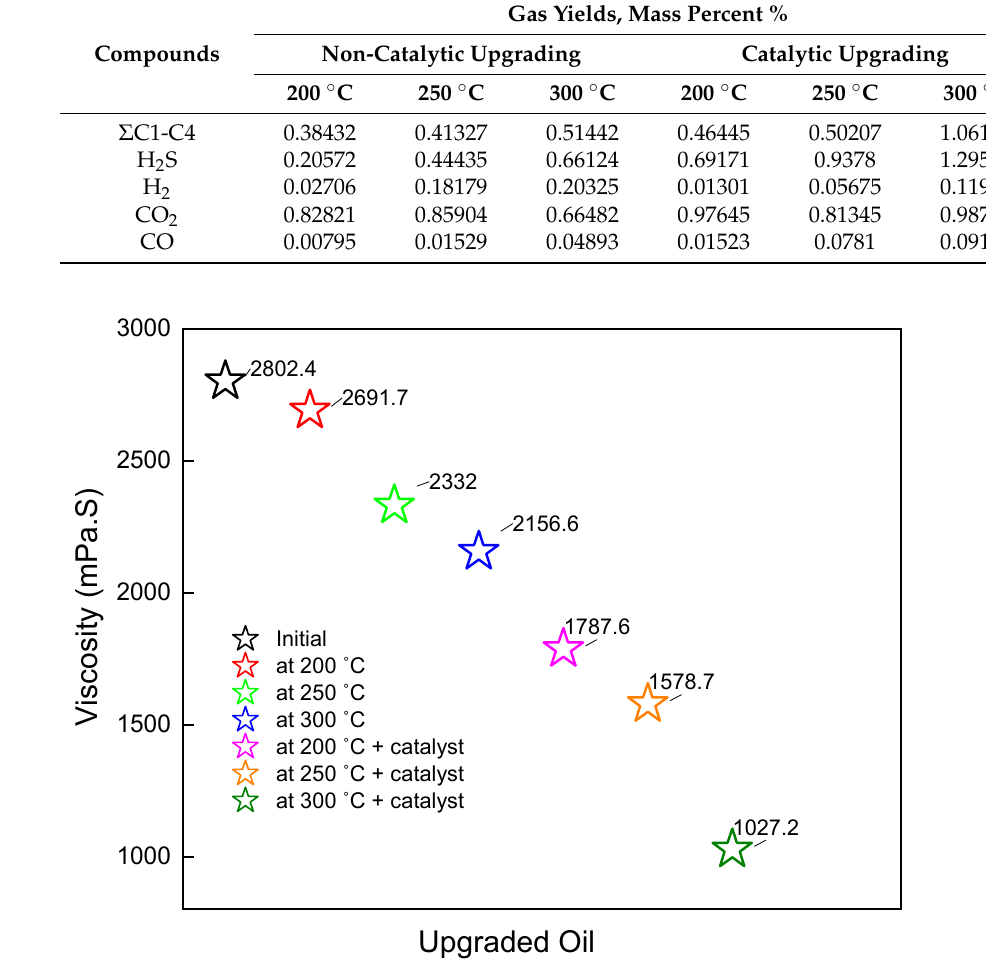
Figure 5. Viscosity measurement at 3.4 cm − 1 share rate before and after catalytic and non-catalytic upgrading of heavy oil at 20 °C.